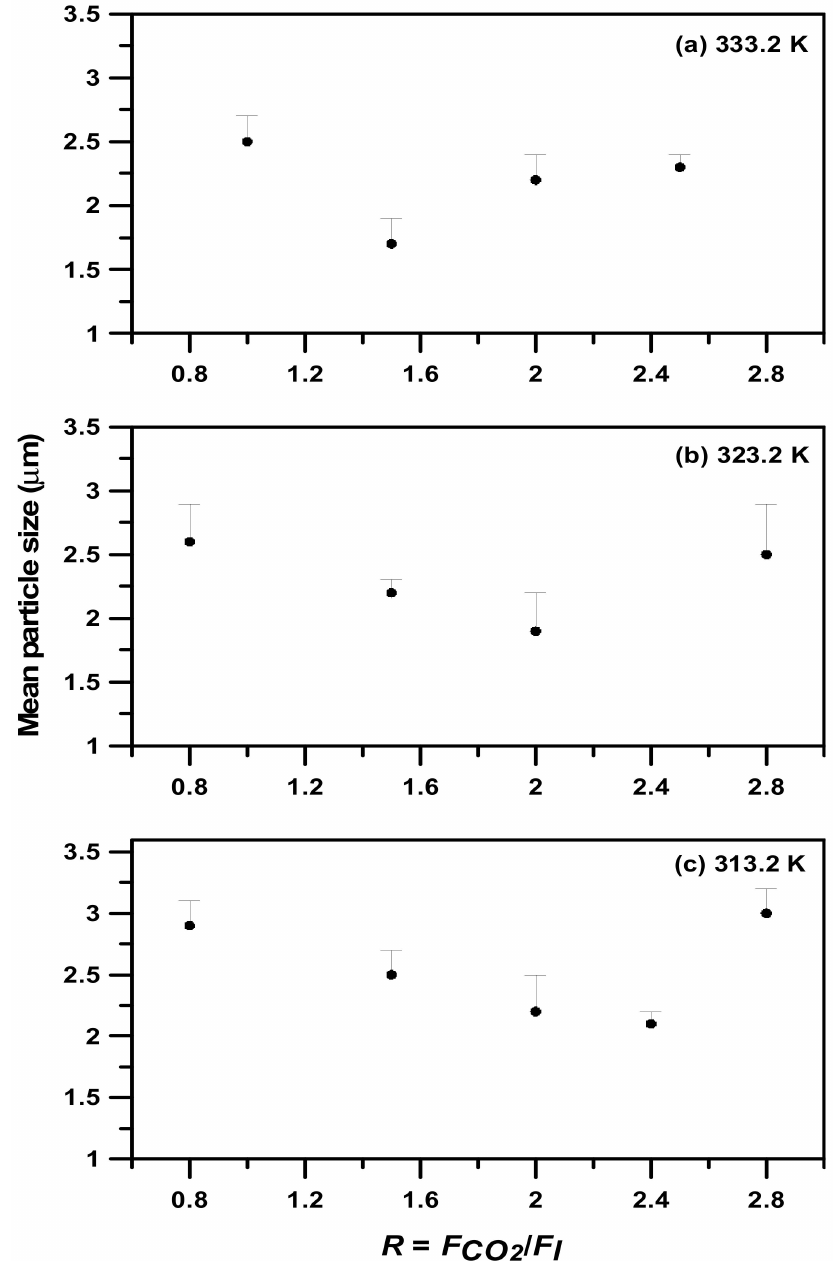
Figure 7. Mass-weighted mean particle size ( (cid:8) ) varying with volume flow ratio ( R ) at C = 10 mg / mL and saturator temperatures: ( a ) T S = 333.2 K, ( b ) T S = 323.2 K, ( c ) T S = 313.2